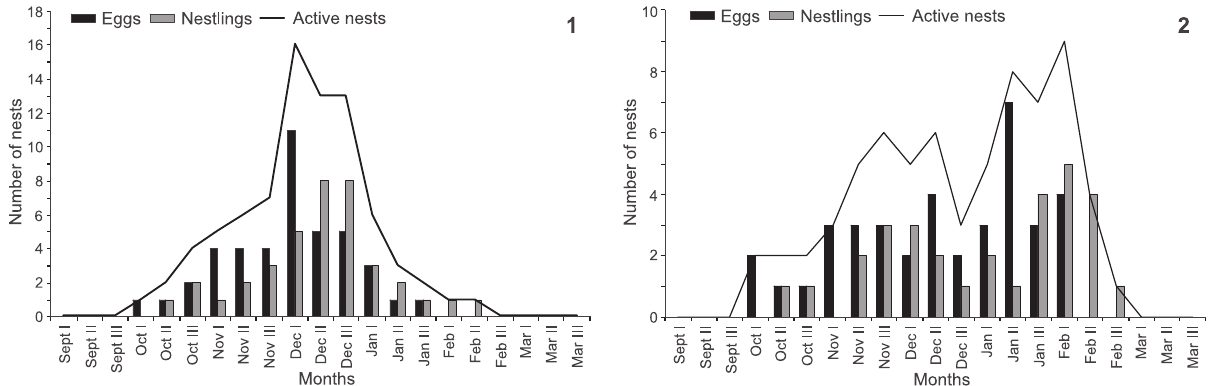
Figures 1–2. Seasonal distribution of active Tyrannus melancholicus nests and nests with eggs or nestlings at Setiba Environmental Protection Area, Brazil, during the breeding seasons of 2012/2013 ( 1 ) and 2013/2014 ( 2 ). Roman letters indicate 10-day periods of each month: I = from day 1 to 10; II = from day 11 to 20; III = from day 21 to 30 (or